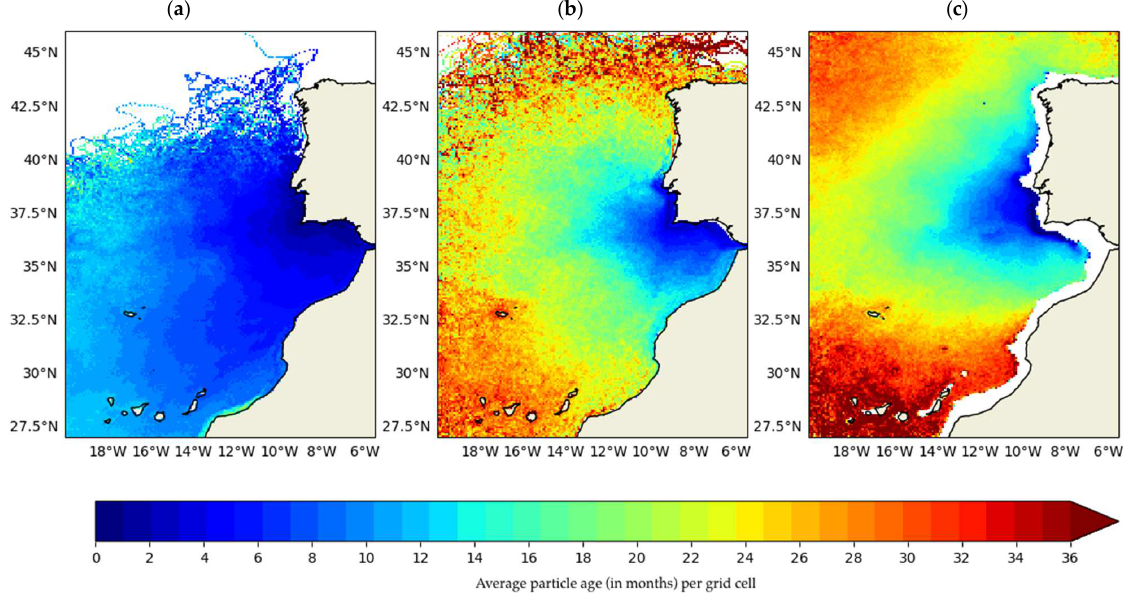
Figure 4. Average age of particles ( a ) at the surface (0 m depth), ( b ) subsurface (30 m depth), and ( c ) deep-water (800 m depth) levels during the entire simulation period, detected in 0.8° grid cells. Color scale is divided into two-month intervals.